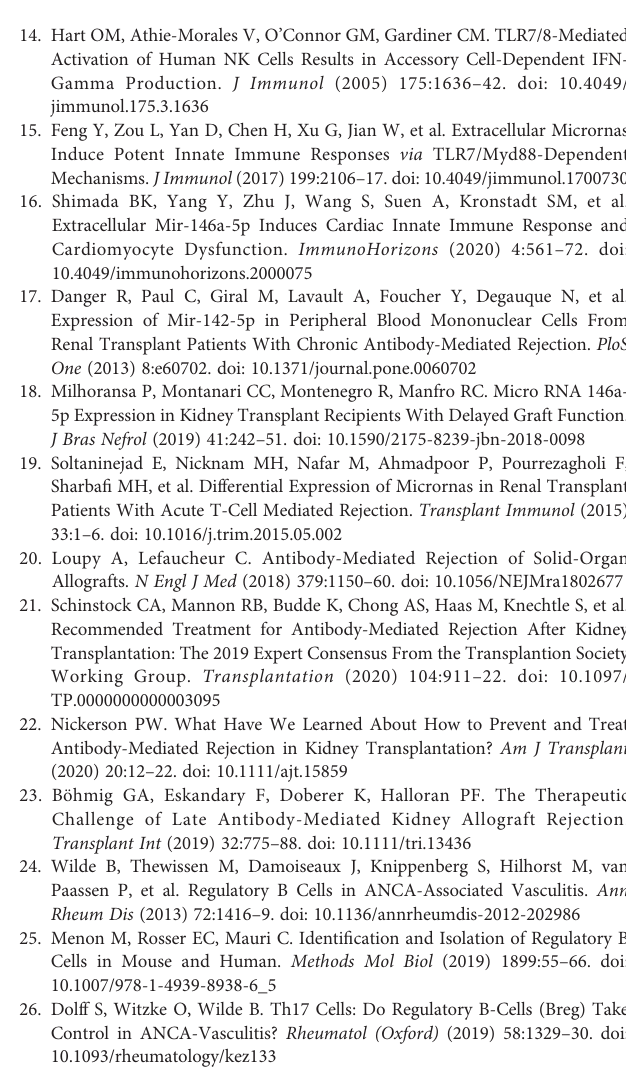
Supplementary Figure 1 | Effect of CQ on GrB producing regulatory B-cells: Representative fl ow cytometric data. Plots are gated on vital B-cells. Supplementary Figure 2 | Effect of CQ on IL-10 producing regulatory B-cells: Representative fl ow cytometric data. Plots are gated on vital B-cells. Supplementary Figure 3 | Effect of CQ on plasma blast formation of B-cells: Representative fl ow cytometric data. Plots are gated on vital B-cells and plasma blasts were de fi ned as CD27 ++ CD38 ++